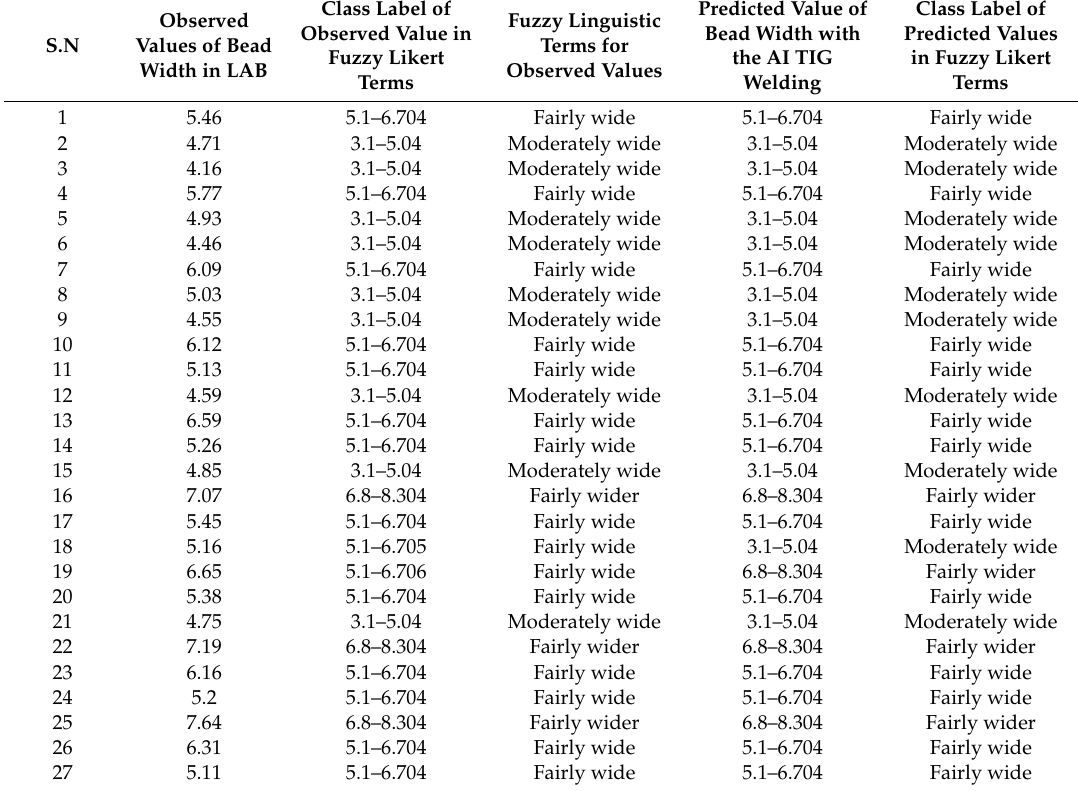
Table 8. Simulation experiment results when the class labels of the predicted values were compared with the observed values from the laboratory